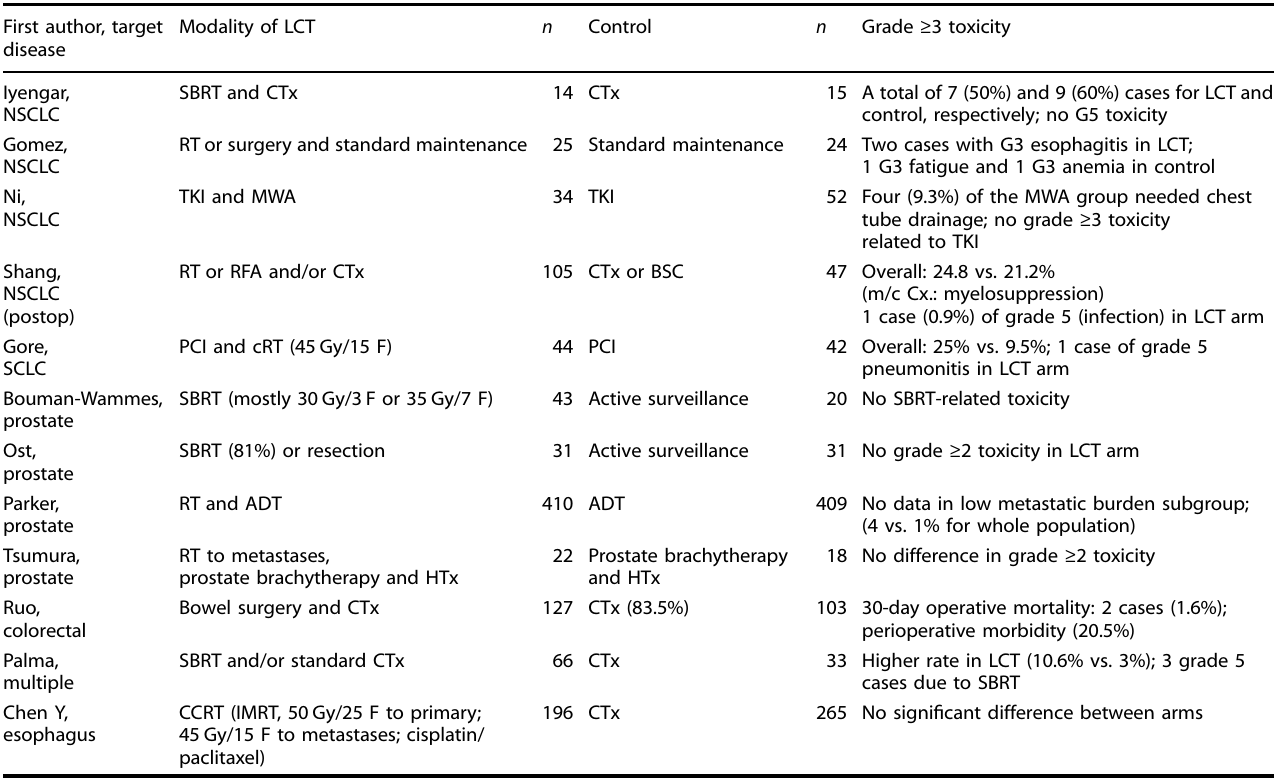
Table 5. Assessment of